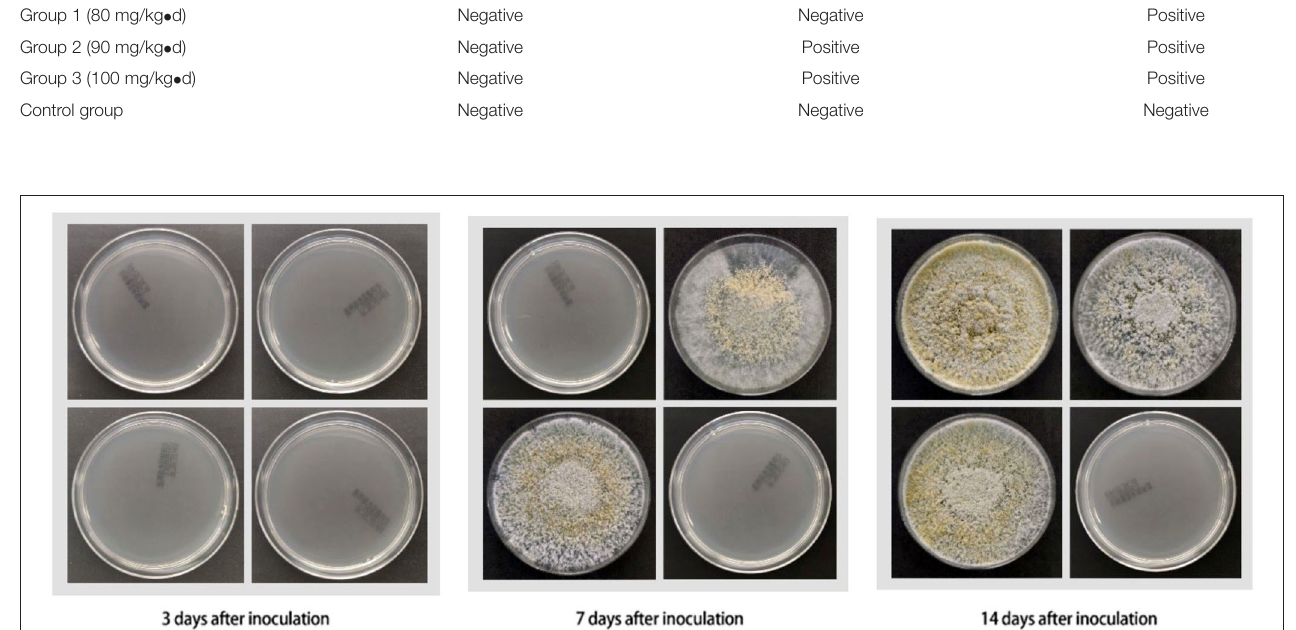
lymphocytes and NK cells (11). Granzyme B belongs to the family of serine proteases expressed by cytotoxic T lymphocytes and NK cells and is a key component of immune